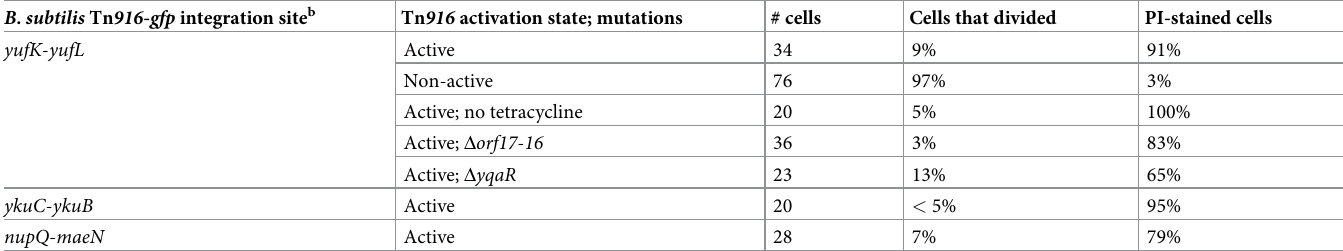
Table 1. Growth defects caused by an active Tn 916 in various host strains a